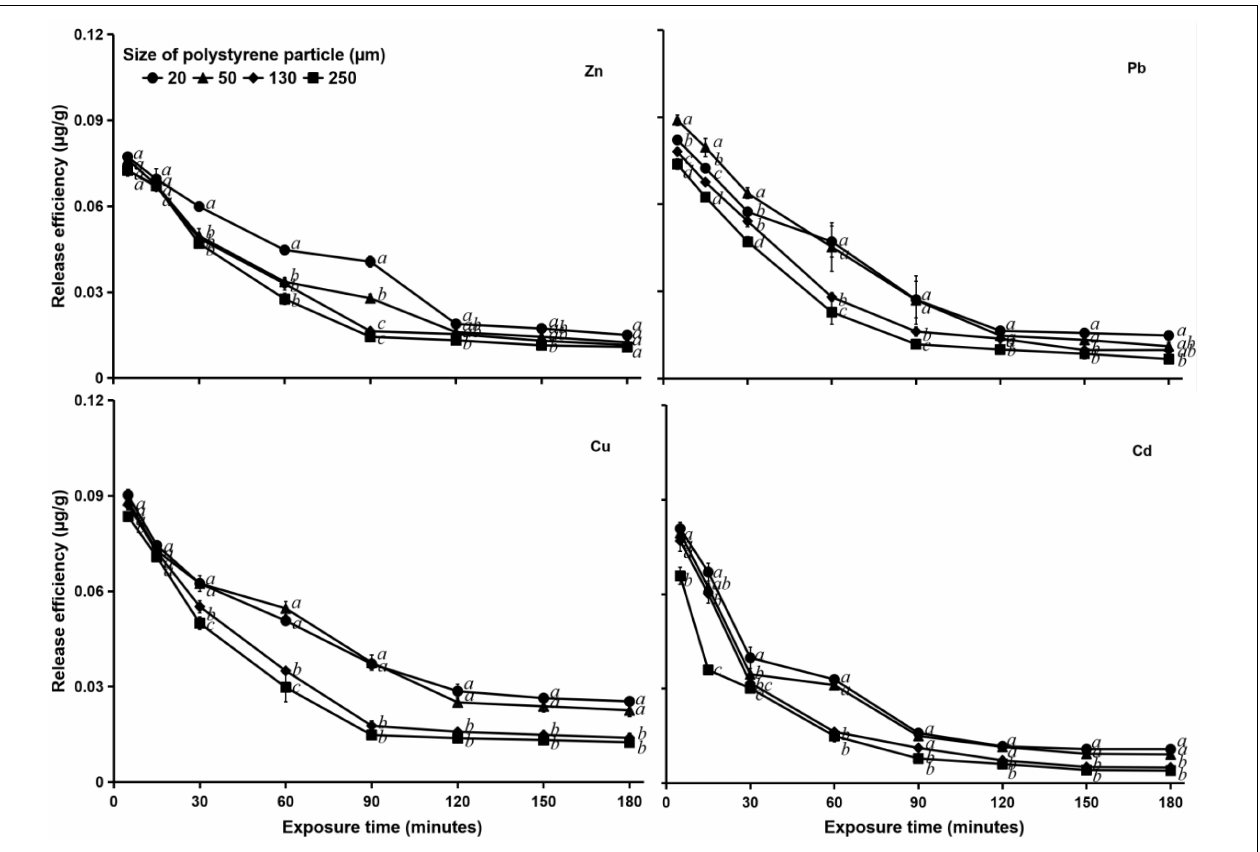
FIGURE 6 | Heavy metal (Zn, Pb, Cu, and Cd) release efficiency ( µ g g − 1 ) in different sizes (20, 50, 130, and 250 µ m) of MPs in water with a salinity of